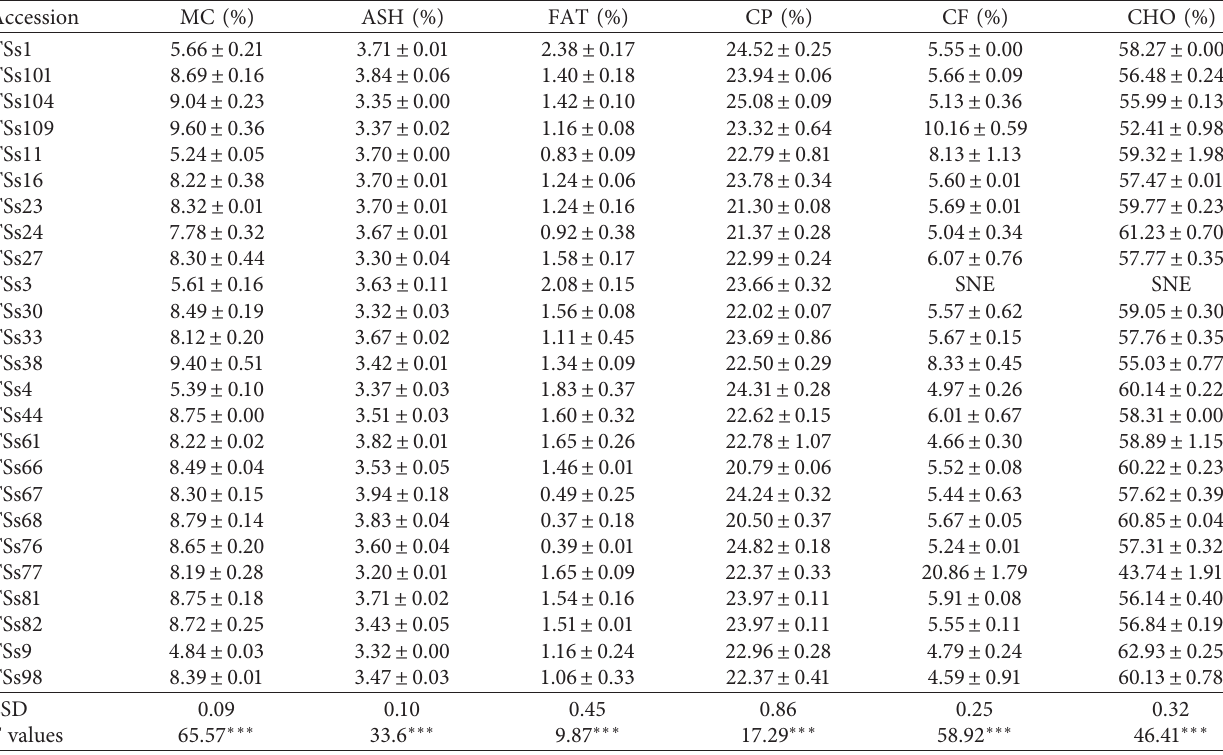
Table 2: Proximate composition (mean ± standard deviation) of processed flour.